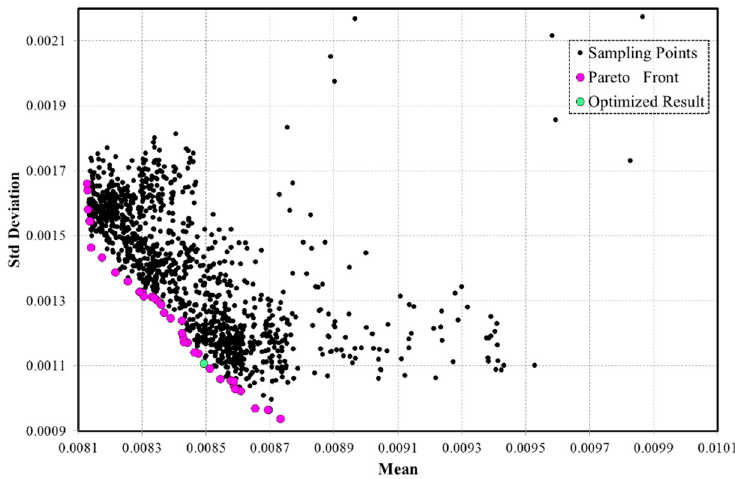
Figure 14. Robust optimization pareto front based on triangular probability distribution.